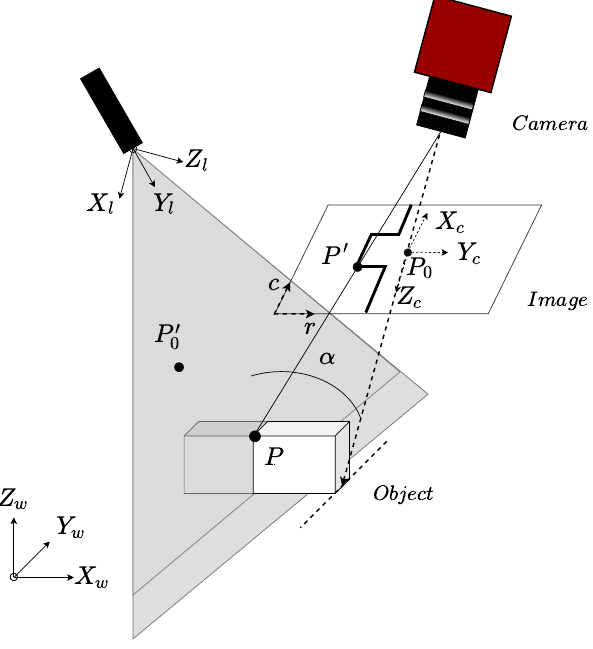
Figure 2. General configuration of a laser triangulation